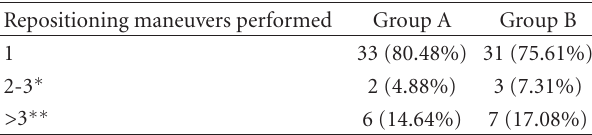
Table 2: Number of repositioning maneuvers performed.